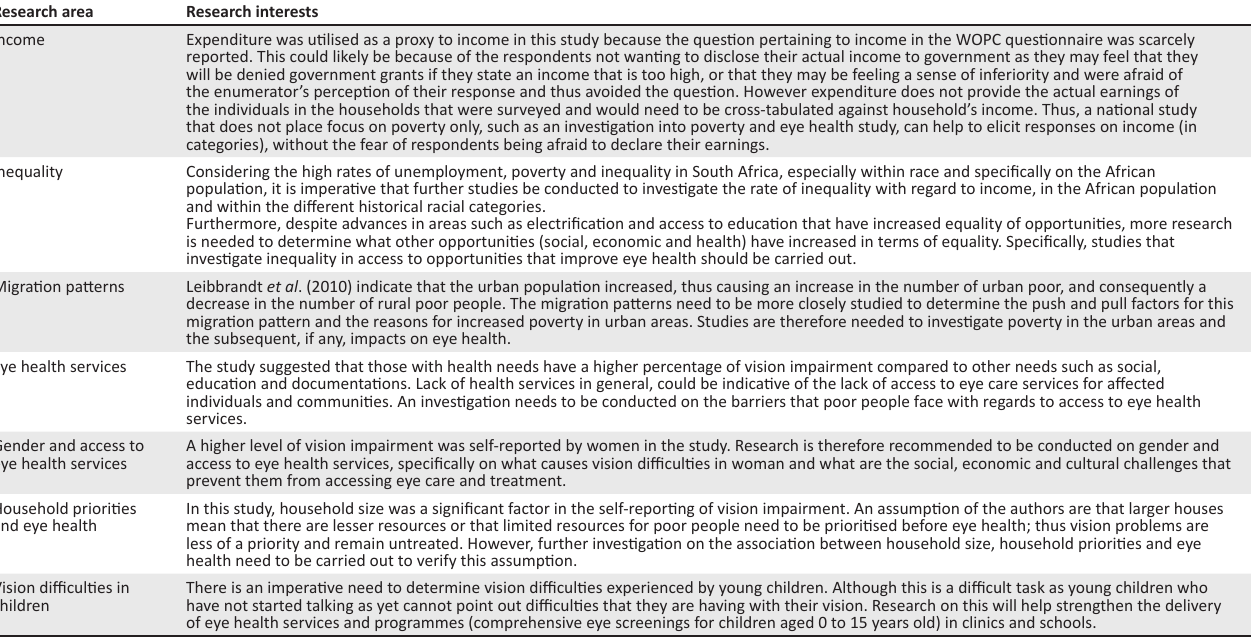
TABLE 3: Research areas emanating from the